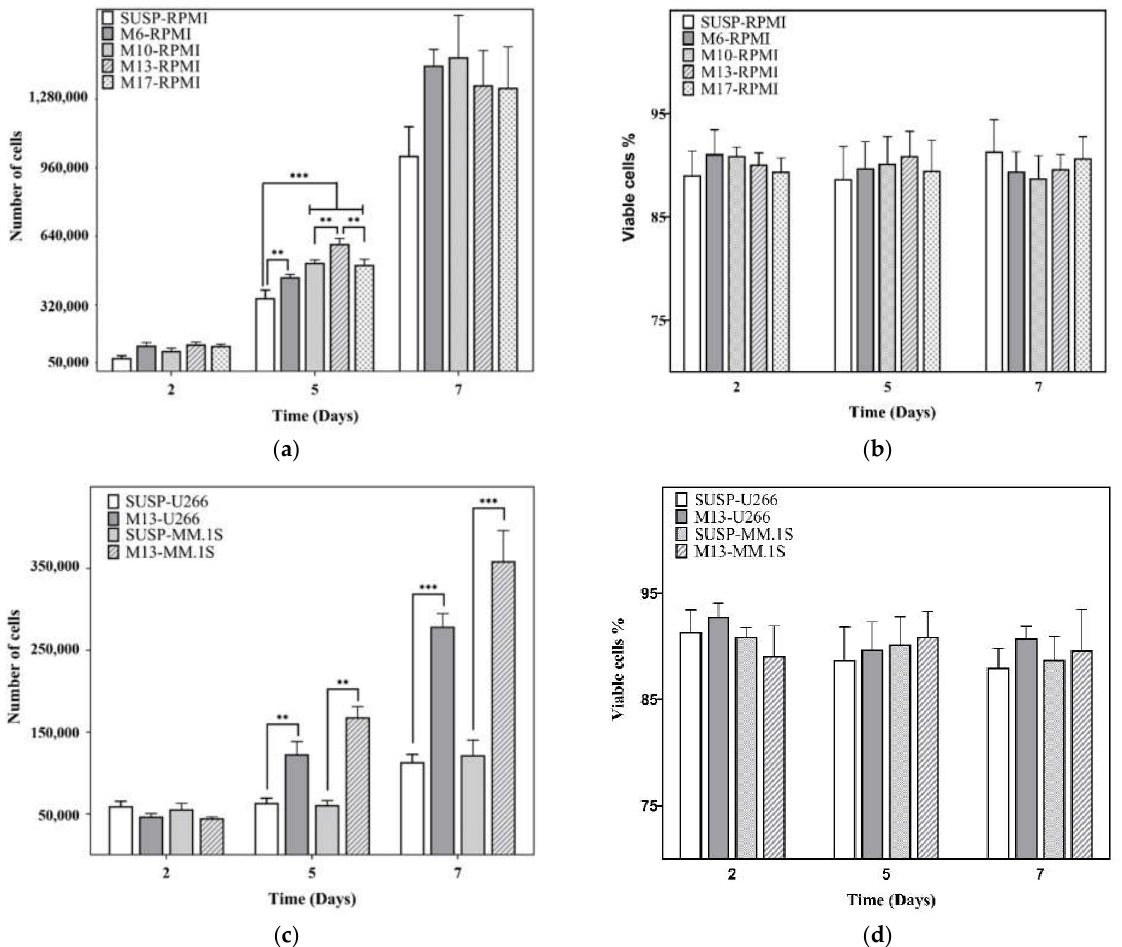
Figure 2. Evaluation of cell proliferation ( a ) and viability ( b ) on the RPMI8226 cell line at different volume ratios of uncoated microgels. Assessment of cell proliferation ( c ) and viability ( d ) on U266 and MM.1S cell lines at M13 volume ratio. SUSP: suspension culture without microspheres; M: suspension culture with different volume ratios of uncoated microspheres; M6: 6.89% v / v of microspheres; M10: 10.34% v / v of microspheres; M13: 13.8% v / v of microspheres; M17: 17.2% v / v of microspheres. Graphics depict mean ± standard deviation. Level of statistical significance: (**) p -value ≤ 0.01, (***) p -value ≤